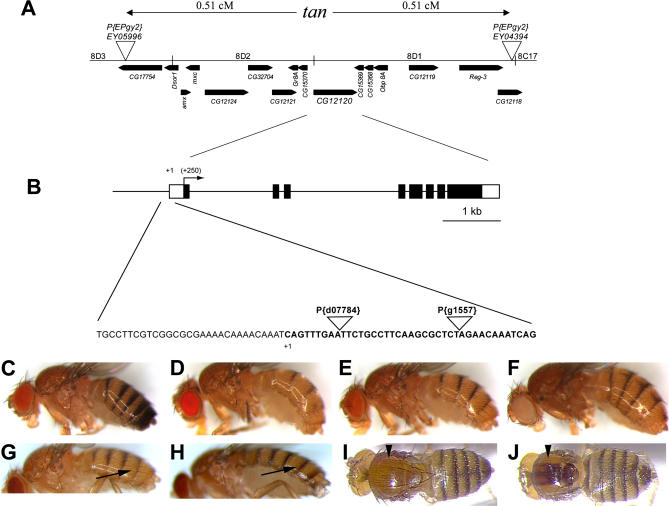

P-Element Insertions in CG12120 Cause tan-Like Pigmentation Phenotypes and Ectopic Expression of CG12120 Rescues the tan Phenotype and Causes Ectopic Melanin Formation(A) The tan region of the D. melanogaster X chromosome. Known and predicted genes with directions of transcription are depicted below the line. Cytological divisions and flanking P-element insertions, as well as meiotic mapping data (see text), are indicated above the line.(B) Transcription unit of predicted gene CG12120. Boxes indicate exons. Black indicates coding region. Transcription start site, inferred from EST data [15], is at the position designated +1. Start codon is at position +250. Below are indicated positions of P{d07784} and P{g1557} insertions, just 3′ to the transcription initiation site (+1) of CG12120. Transcription unit is indicated in bold.(C–F) Adult (3–5 d) female body coloration of (C) CantonS (wild-type), (D) tan5, (E) w P{d07784}, and (F) w P{g1557}.(G and H) w tan1/w tan1; CyO/+; P{w+ C765-GAL4}/+ control female (G) and w tan1/w tan1; P{w+ UAS-CG12120}/+; P{ w+ C765-GAL4}/+ female (H) showing rescue of abdomen phenotype (arrows).(I and J) w/w; CyO/+; P{w+ pnr-GAL4}/+ control female (I) and w/w; P{w+ UAS-CG12120}/+; P{w+ pnr-GAL4}/+ female (J) showing ectopic melanin pattern along dorsal midline (arrowheads).All flies depicted were 3–5 d of age.